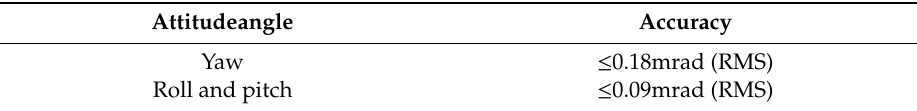
Table 1. GPS / INS unit attitude measurement accuracy.